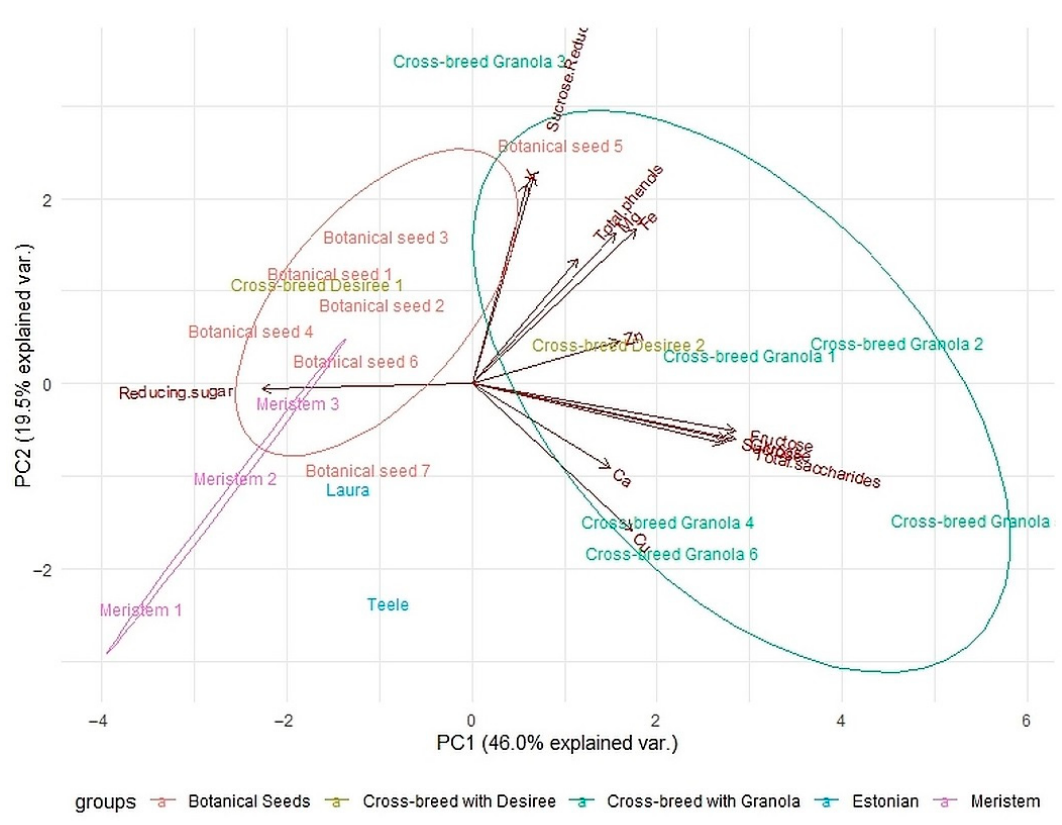
Figure 2. Electropherograms of sugar analysis from sweet potato tuber Sample 21 (blue), purple- fleshed cross-breed with Granola Sample 14 (red) and a meristem clone of Blue Congo sample 16 (green). Identification 1—myo-inositol, 2—sucrose, IS—internal standard, 3—maltose, 4—glucose, Figure 4. As the PC1 and PC2 had a total explained variance of 65.5%, the PCA was determined to 5—fructose. be successful.